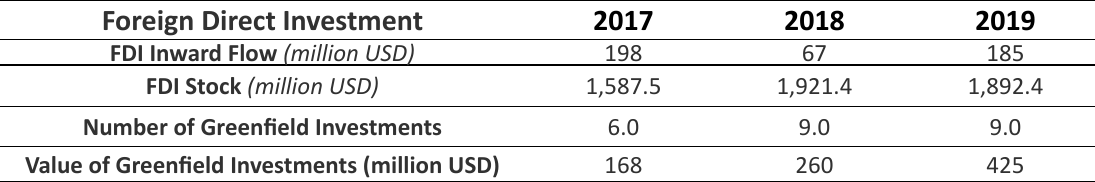
Table 4: Foreign Direct Investment Inflow and Greenfield Investments in Millions USD Foreign Direct Investment